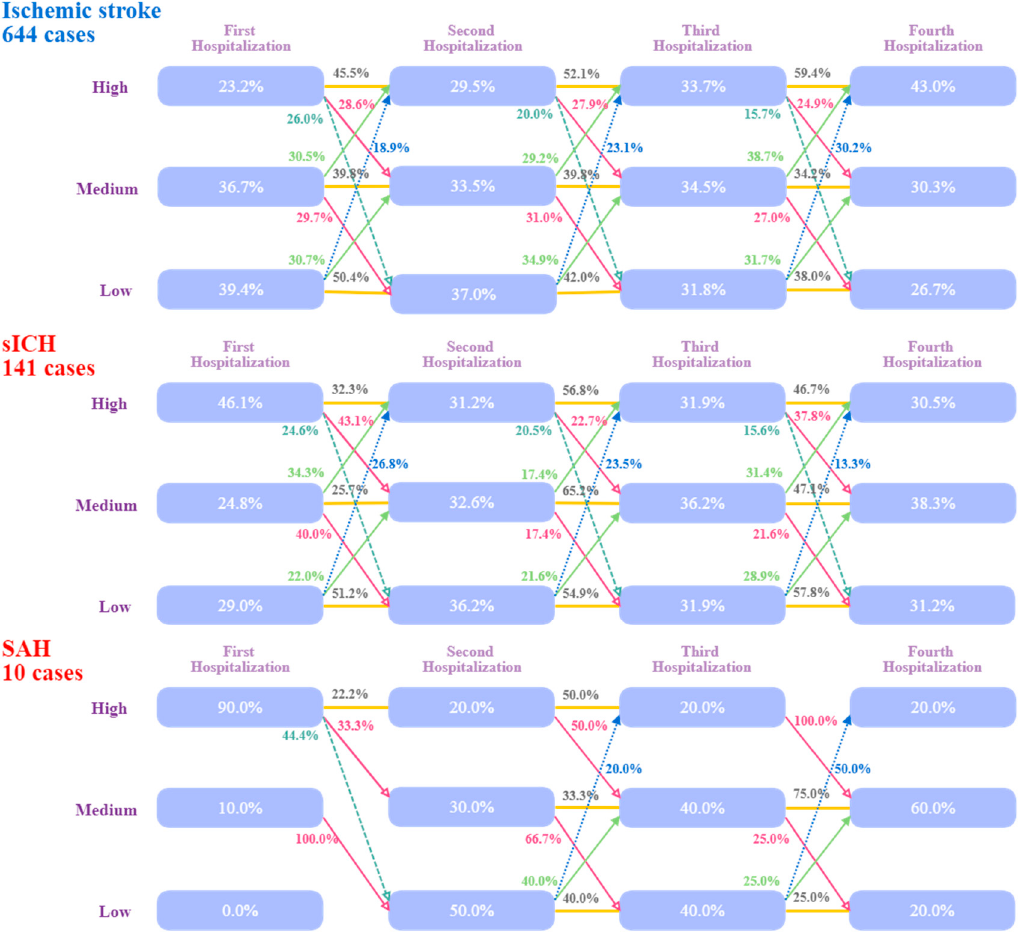
Figure 3. Group-based trajectory model (GBTM) of medical expenditure of stroke patients according to type of stroke. As the number of cases was relatively low, GBTM was used to evaluate SAH cases for reference only. The proportions of sICH and SAH patients in the high medical expenditure group were relatively higher than the proportion of ischemic stroke patients at the first admission. Patients increasingly moved to groups of higher medical expenditure at subsequent admissions, regardless of stroke type.